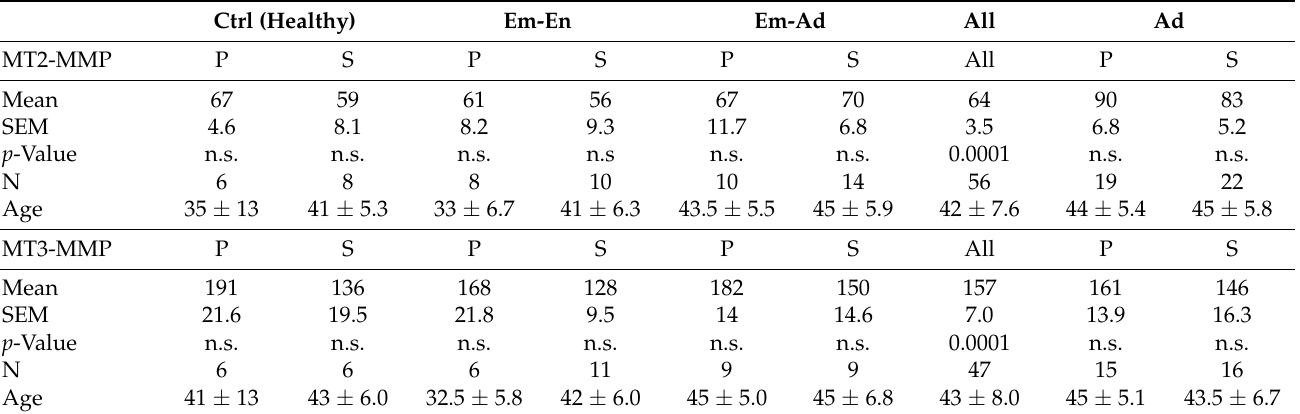
Table 3. Comparison of MT2/3-MMP in proliferative and secretory phases of endometrium of patients with and without endometriosis and adenomyosis using the HSCORE.